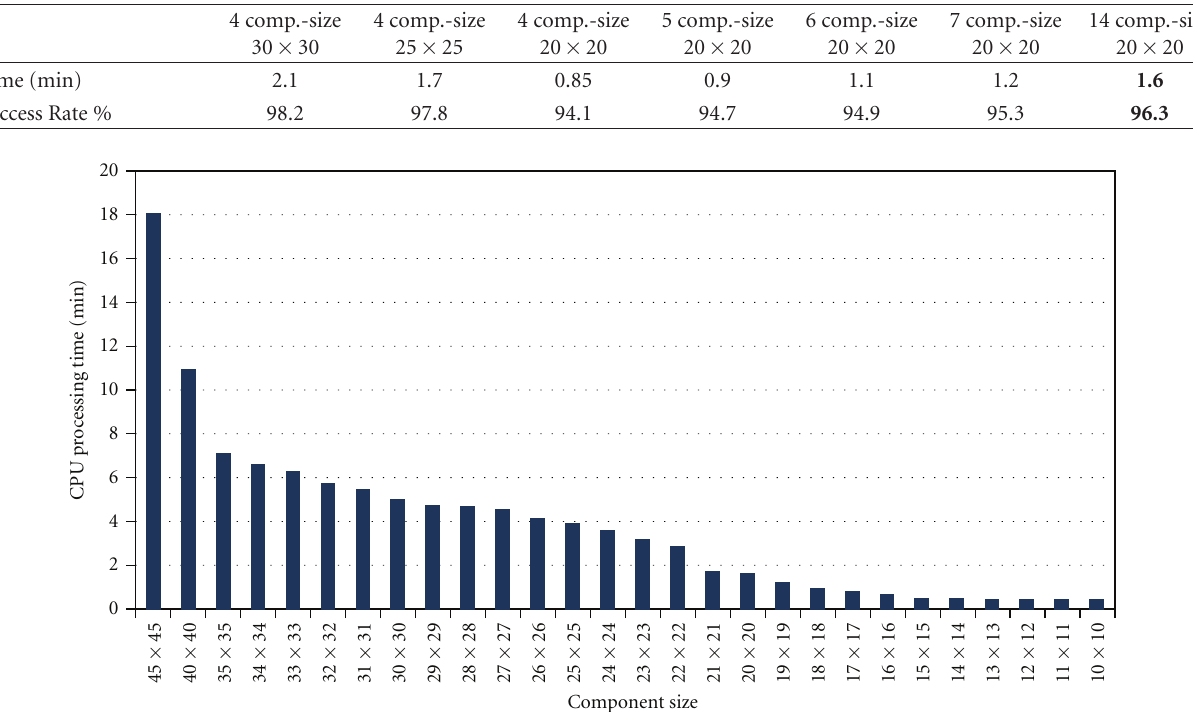
Figure 5: Computation time for a single block (component) for the xm2vts (C1) database